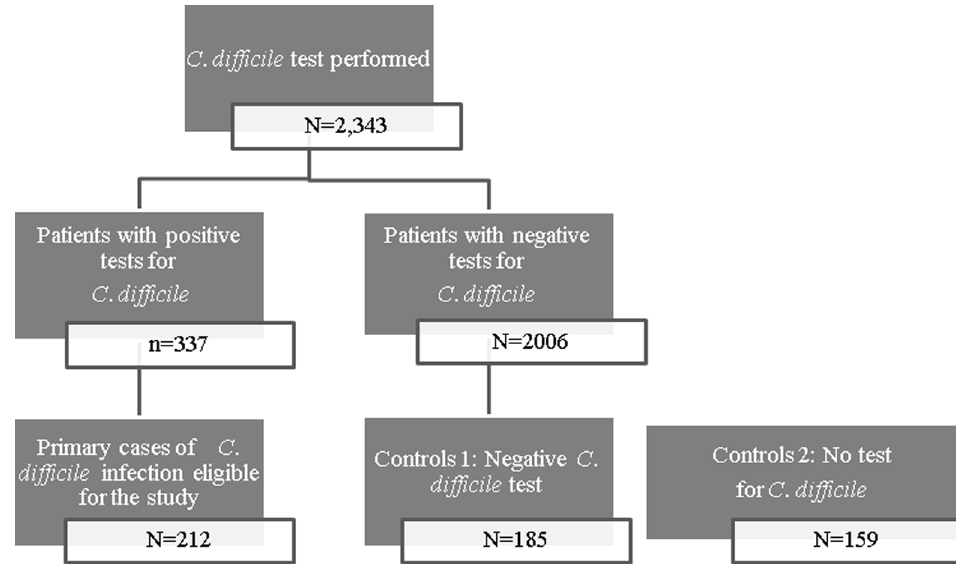
Figure 1. Flowchart of enrolled patients.